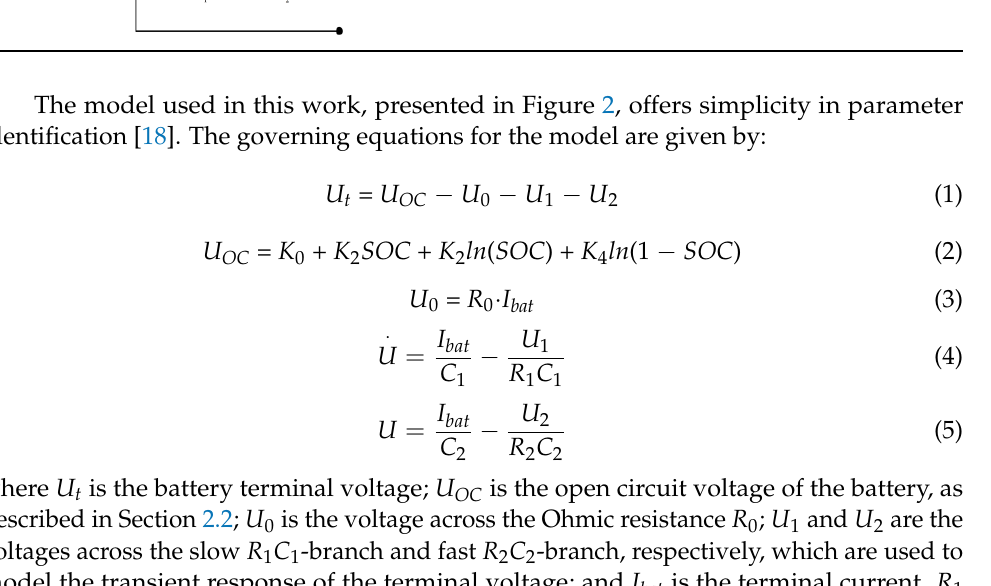
Figure 1. Thevenin equivalent circuit model with Nernst OCV–SOC relation used as the baseline model for comparison against Model I.